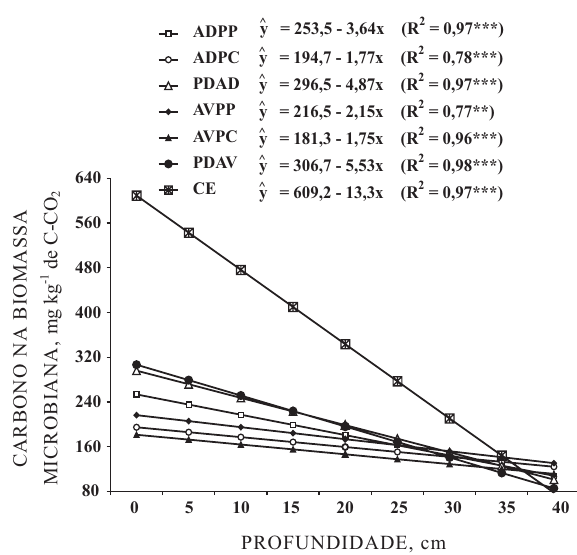
Figura 2. Equações de regressão polinomial não- ortogonal para carbono da biomassa microbiana ( y ^ , mg kg -1 de C-CO no solo) em função da 2 profundidade (cm), considerando todo o período de estudo. ***, **: Significativos a 1 e 5 %, respectivamente, pelo teste F. Ver quadro 3 para descrição dos